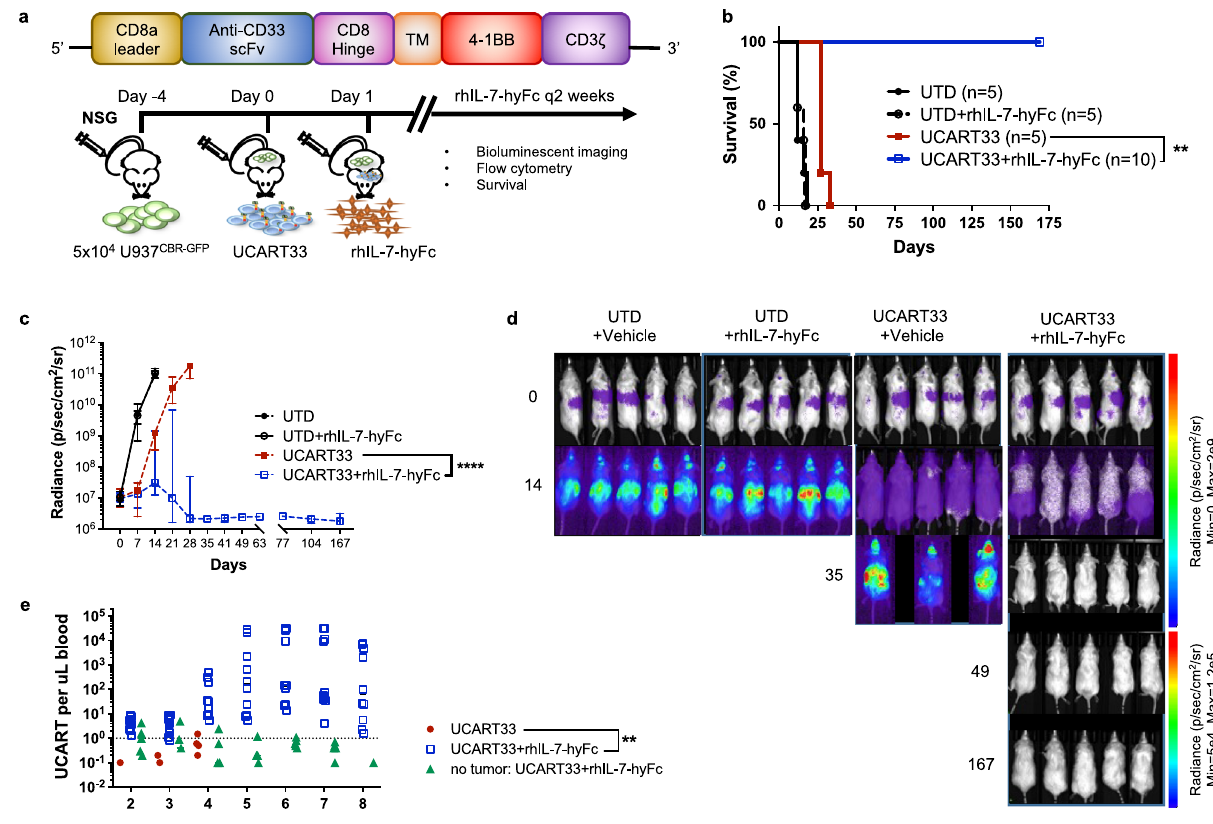
Fig. 3 rhIL-7-hyFc enhances UCART33 expansion, persistence and anti-tumor ef fi cacy in NSG mice engrafted with CD33 + U937 CBR-GFP cells in